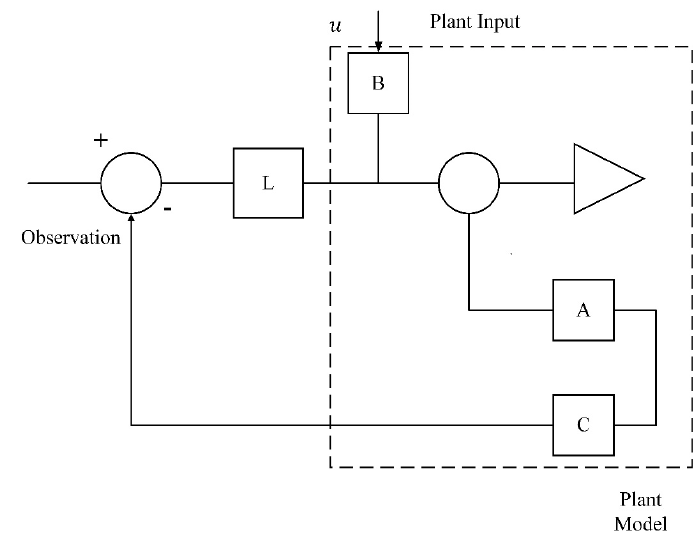
Figure 4. Order Observer .